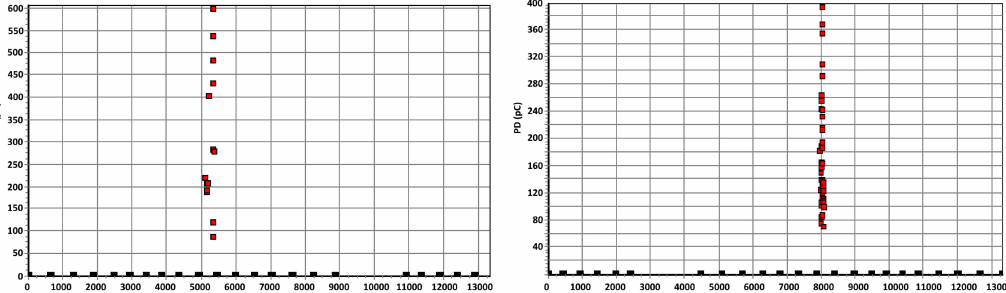
Figure 11. PD Mapping as made up to 1.3 Uo during DAC testing of a 220 kV 13.3 km long cable circuit. The PD concentration at 5.2 km distance indicates the breakdown site of phase L1 (left). Measurement from the other end confirmed this location at 8.1 km